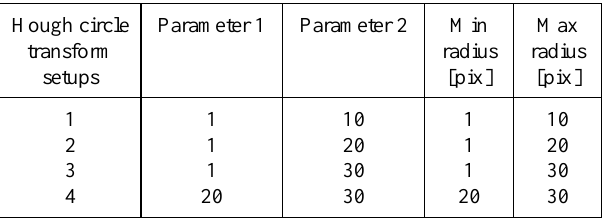
Table 1 . Parameterisation setup for Hough circle transform in OpenCV after a “trial and error”